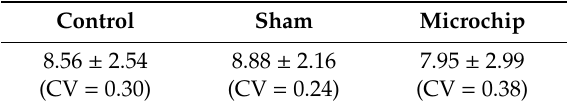
Table 16. MNT values (kg) in response to microchip insertion [20].